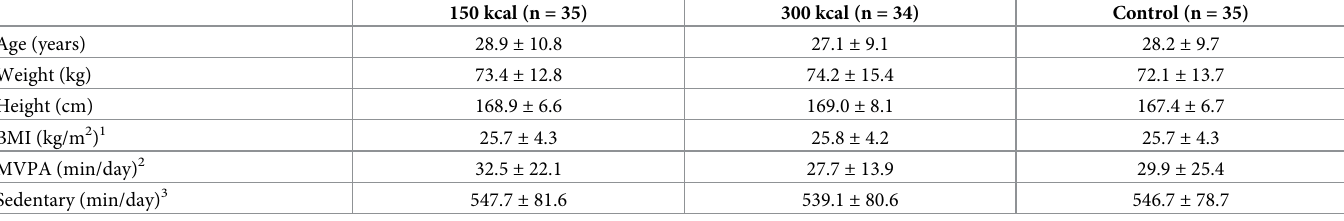
Table 1. Baseline anthropometrics and physical activity of study participants randomized to an exercise intervention expending 150 or 300 kcal per exercise session, 3 days per week for 6-weeks, or to a non-exercise control